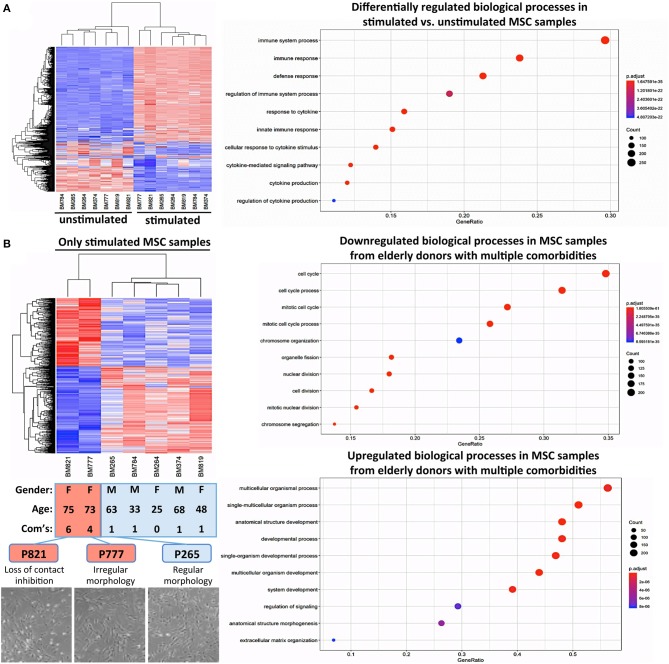
Cytokine challenge reveals altered gene regulation in BMSCs from elderly donors with multiple comorbidities. (A) Comparison of unstimulated vs. cytokine-stimulated BMSCs (n = 7 donors each): hierarchical clustering heat map with expression values sorted according to donors (rows) and genes (columns), where low expression is denoted by blue and high expression by red, and corresponding gene ontology (GO) enrichment analysis with the “Top 10 Results” for changes in biological process (e.g., immune system process and immune and defense response) shown on the left y-axis, and the size of the dots representing the counts of genes involved, while the color of the circle (scaled blue/lowest to red/highest) indicating significance expressed as adjusted p-value. (B) Substratified gene expression analysis focusing only on stimulated samples (n = 7 donors): BMSCs from elderly donors with multiple comorbidities (P777 and P821, with n = 4 and n = 6 comorbidities, respectively) cluster separately from both elderly and adult donors with few comorbidities (P265 and P374; and P264, P784, and P819, respectively, n = 0–1 comorbidities), indicating that the accumulation of multiple comorbidities during advanced age results in a detectable in vivo imprint in the transcriptome of BMSCs. This was accompanied by a decline in cell proliferation and a progression from regular to irregular morphology in culture (representative images at the bottom), resulting in a progressive loss of contact inhibition and cell aggregation. Analysis of the biological processes, showing that P777 and P821 differ under stimulating conditions from the other donors, identified significant downregulation of processes associated with cell proliferation (e.g., mitotic cell cycle, cell division, and chromosome organization), while upregulated processes entailed categories associated with cell differentiation (e.g., multicellular organism process, anatomic structure development, morphogenesis, and ECM organization).